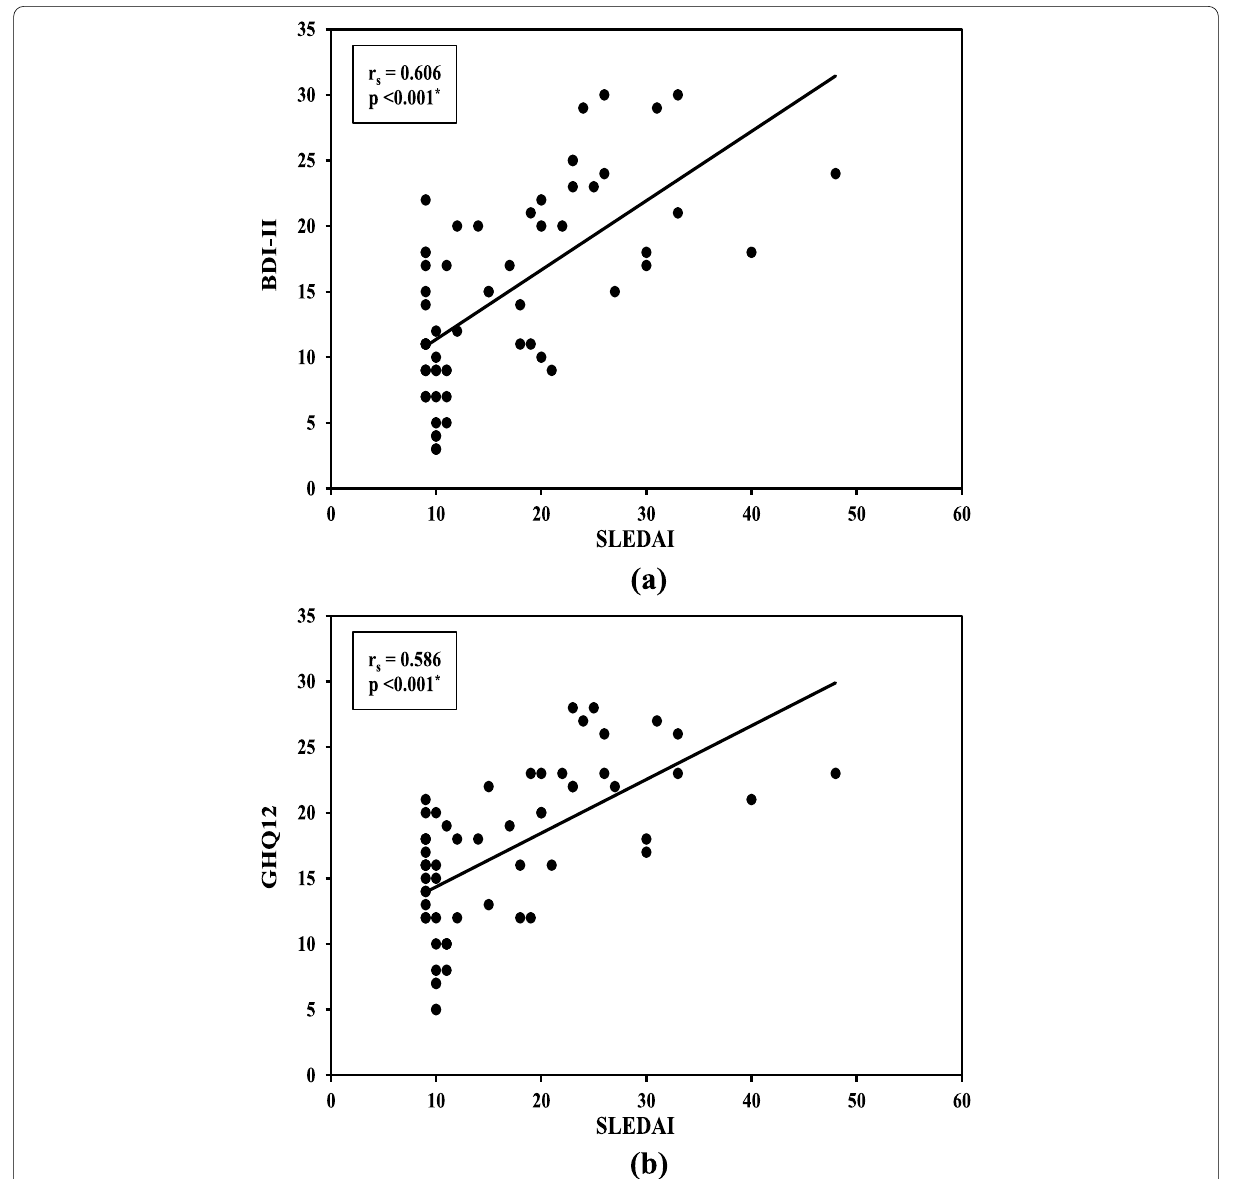
Fig. 3 a Correlation between SLEDAI-2 K with BDI-II in SLE patients ( n